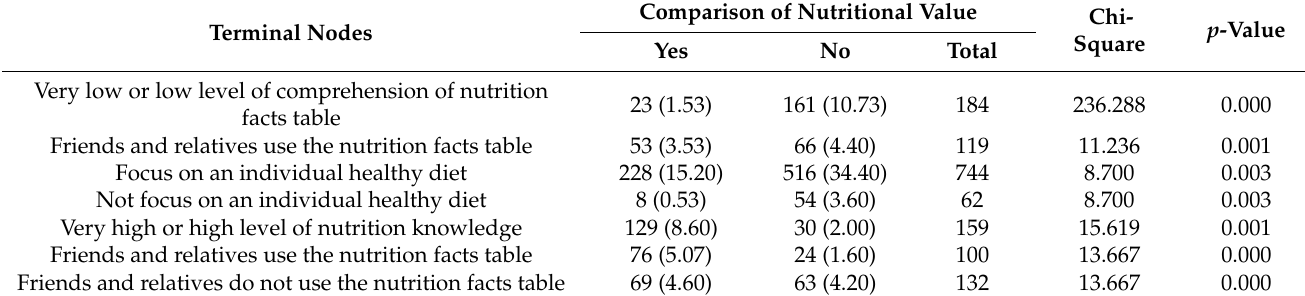
Table 4. Chi-square test results of terminal nodes [ n